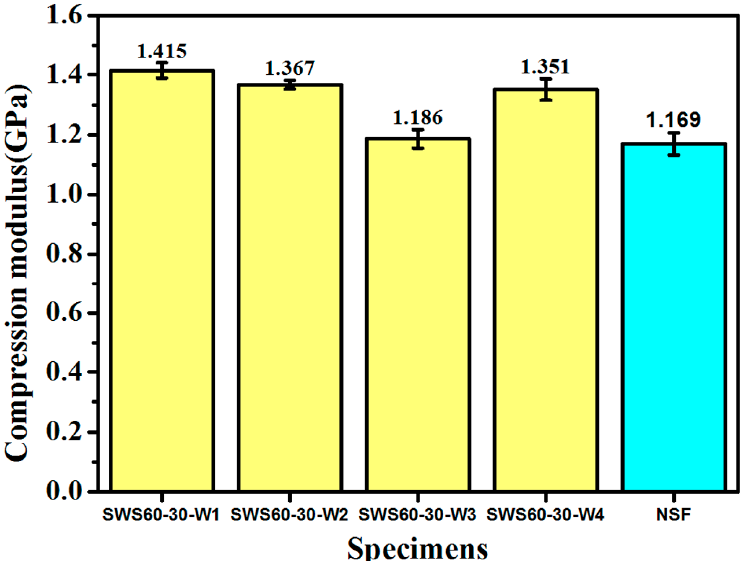
Figure 4. The compressive modulus of WKSF-SF and neat syntactic foam (NSF) according to the quasi-static compression test. Polymers 2020 , 12 , x